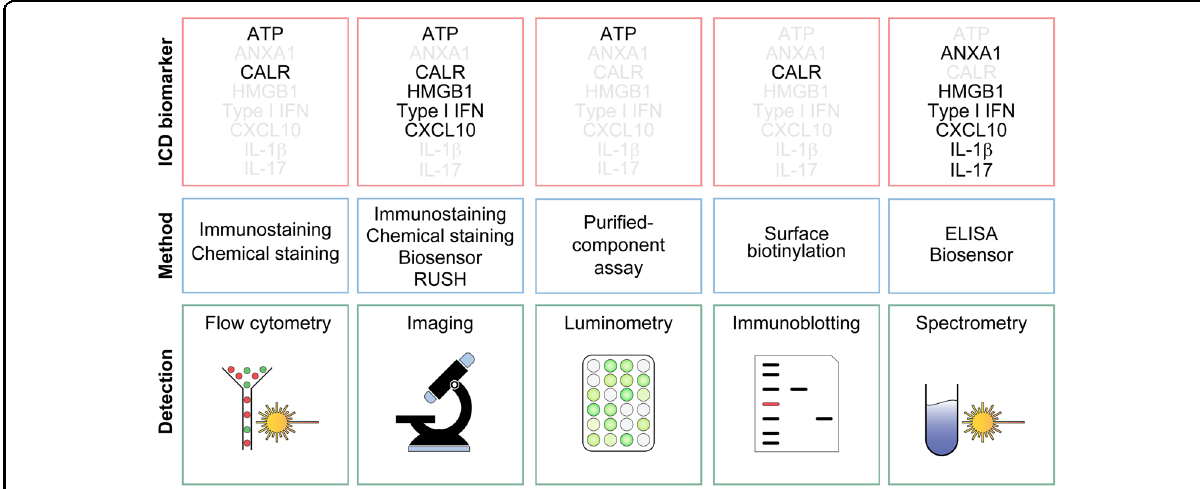
Fig. 2 Main methodological approaches to measure ICD biomarkers in vitro. The main hallmarks of immunogenic cell death (ICD) can be assessed by fl ow cytometry, (immuno) fl uorescence microscopy, immunoblotting, or luminometry, based on a variety of different approaches. ANXA1, annexin A1; CALR, calreticulin, CXCL10, C-X-C motif chemokine ligand 10; HMGB1, high-mobility group box 1; IFN, interferon; IL-1 β (of fi cial